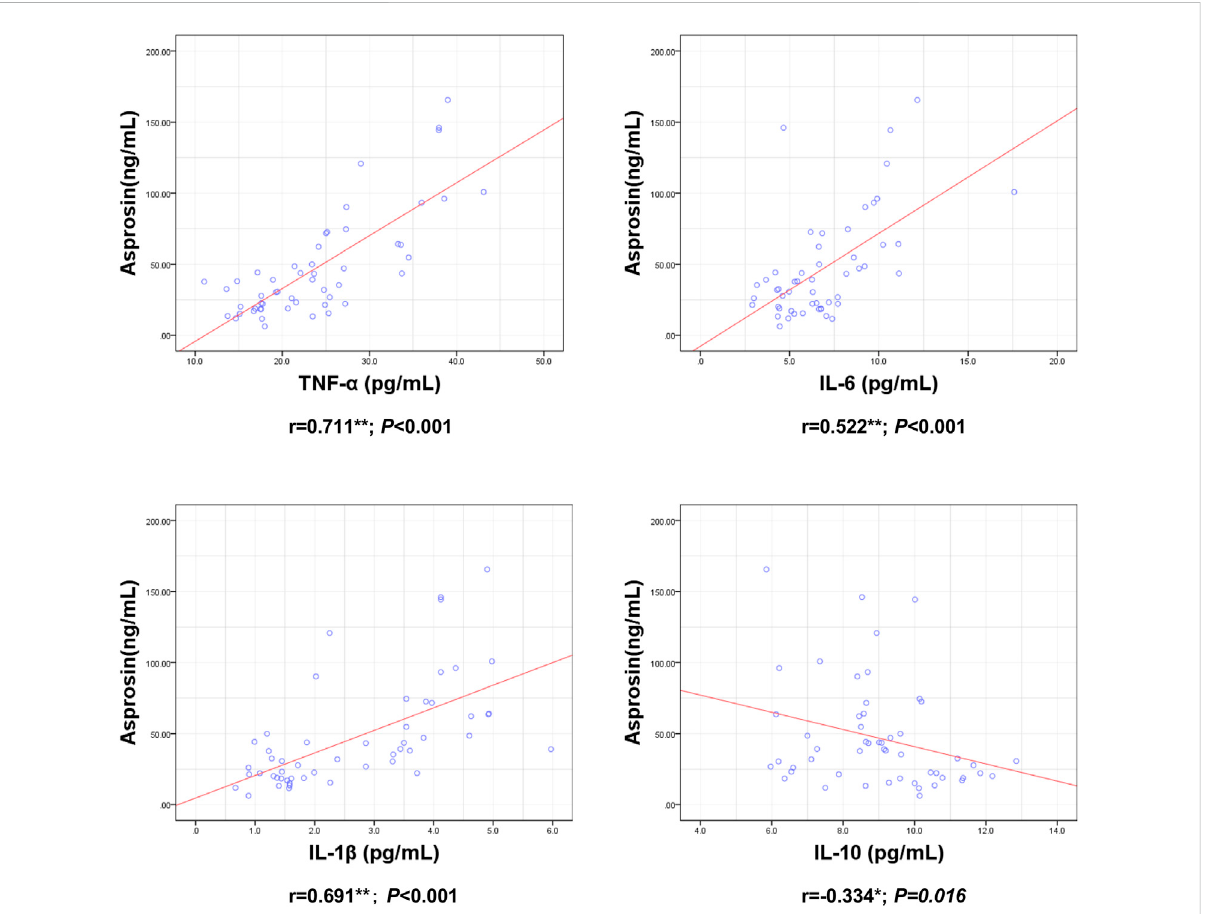
FIGURE 5 Correlation between Serum asprosin and in fl ammatory factors. r-correlation coef fi cient, p < 0.05 — level of statistical signi fi cance.